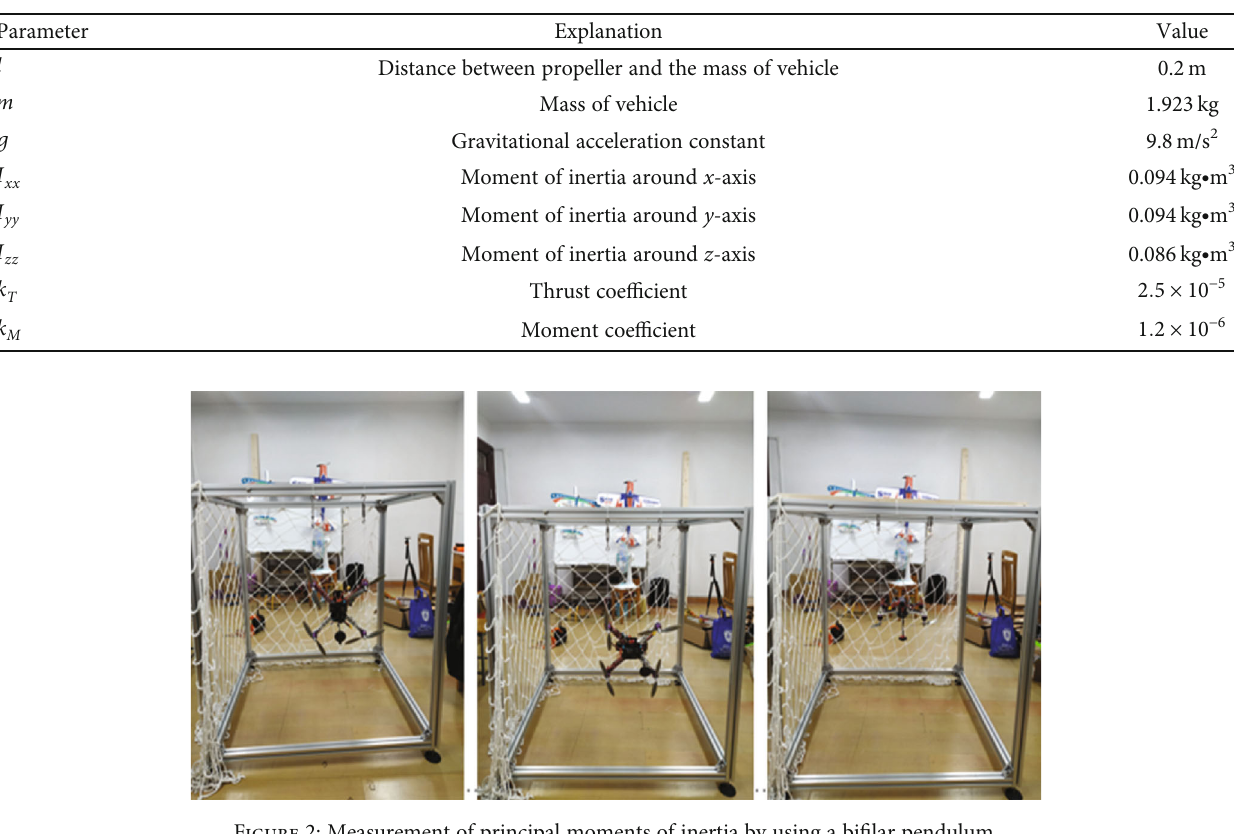
Table 1: Physical parameters of the quadrotor.